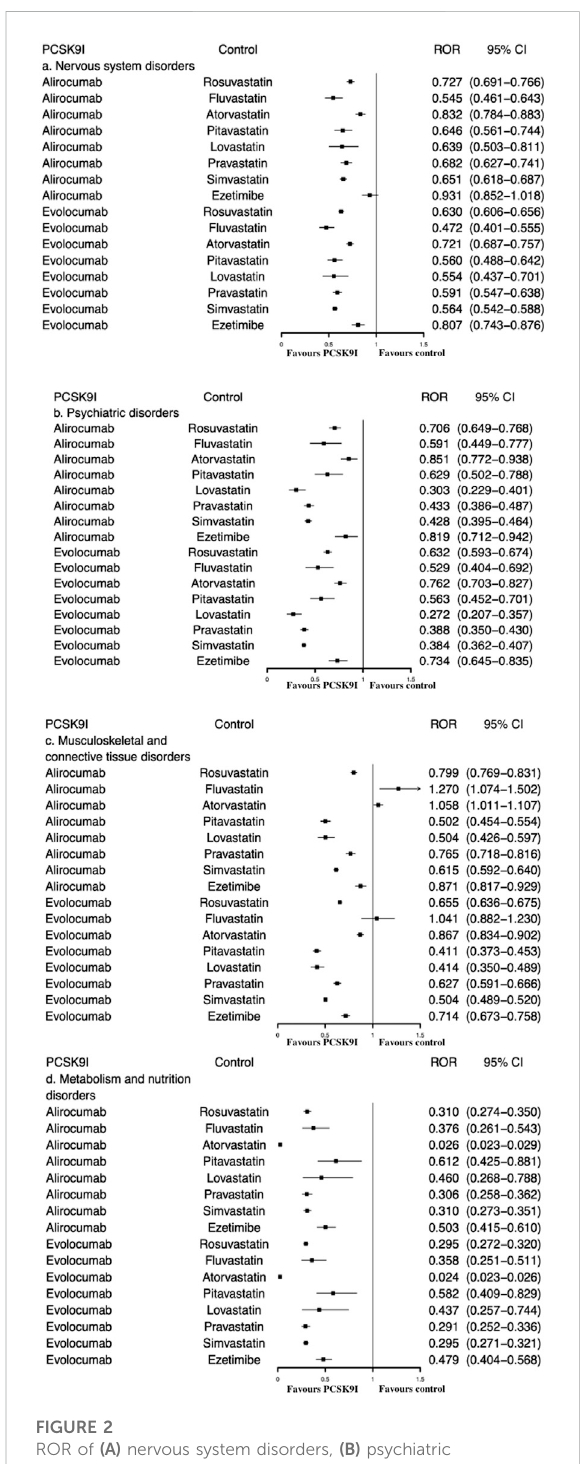
FIGURE 2 ROR of (A) nervous system disorders, (B)